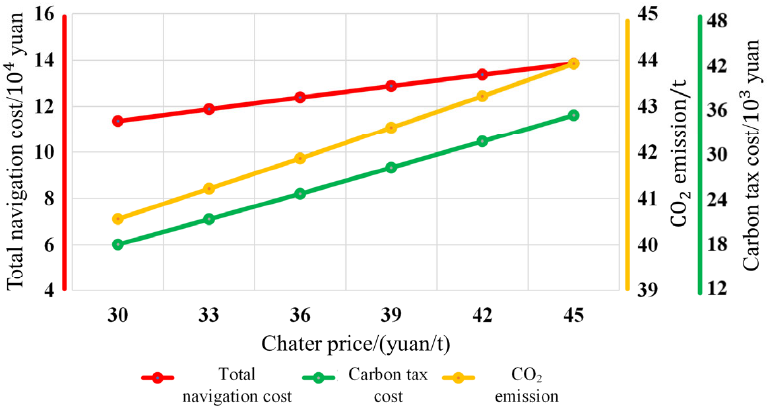
Figure 18. Total shipping costs, carbon tax costs, and CO 2 emissions at different charter rates.